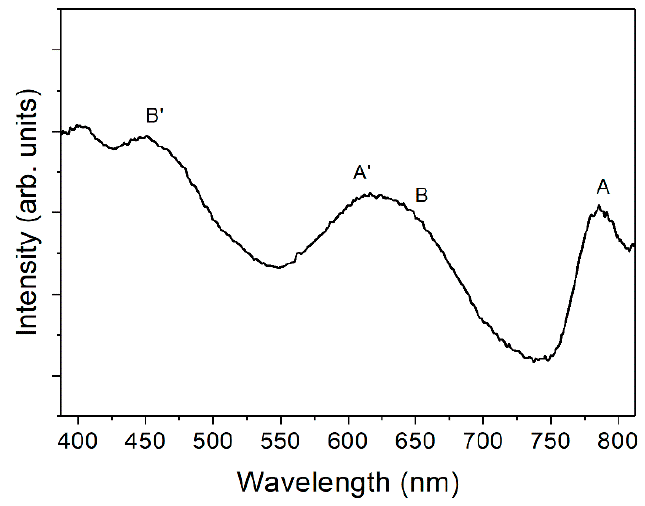
Figure 6. UV–VIS spectrum of WSe 2 .